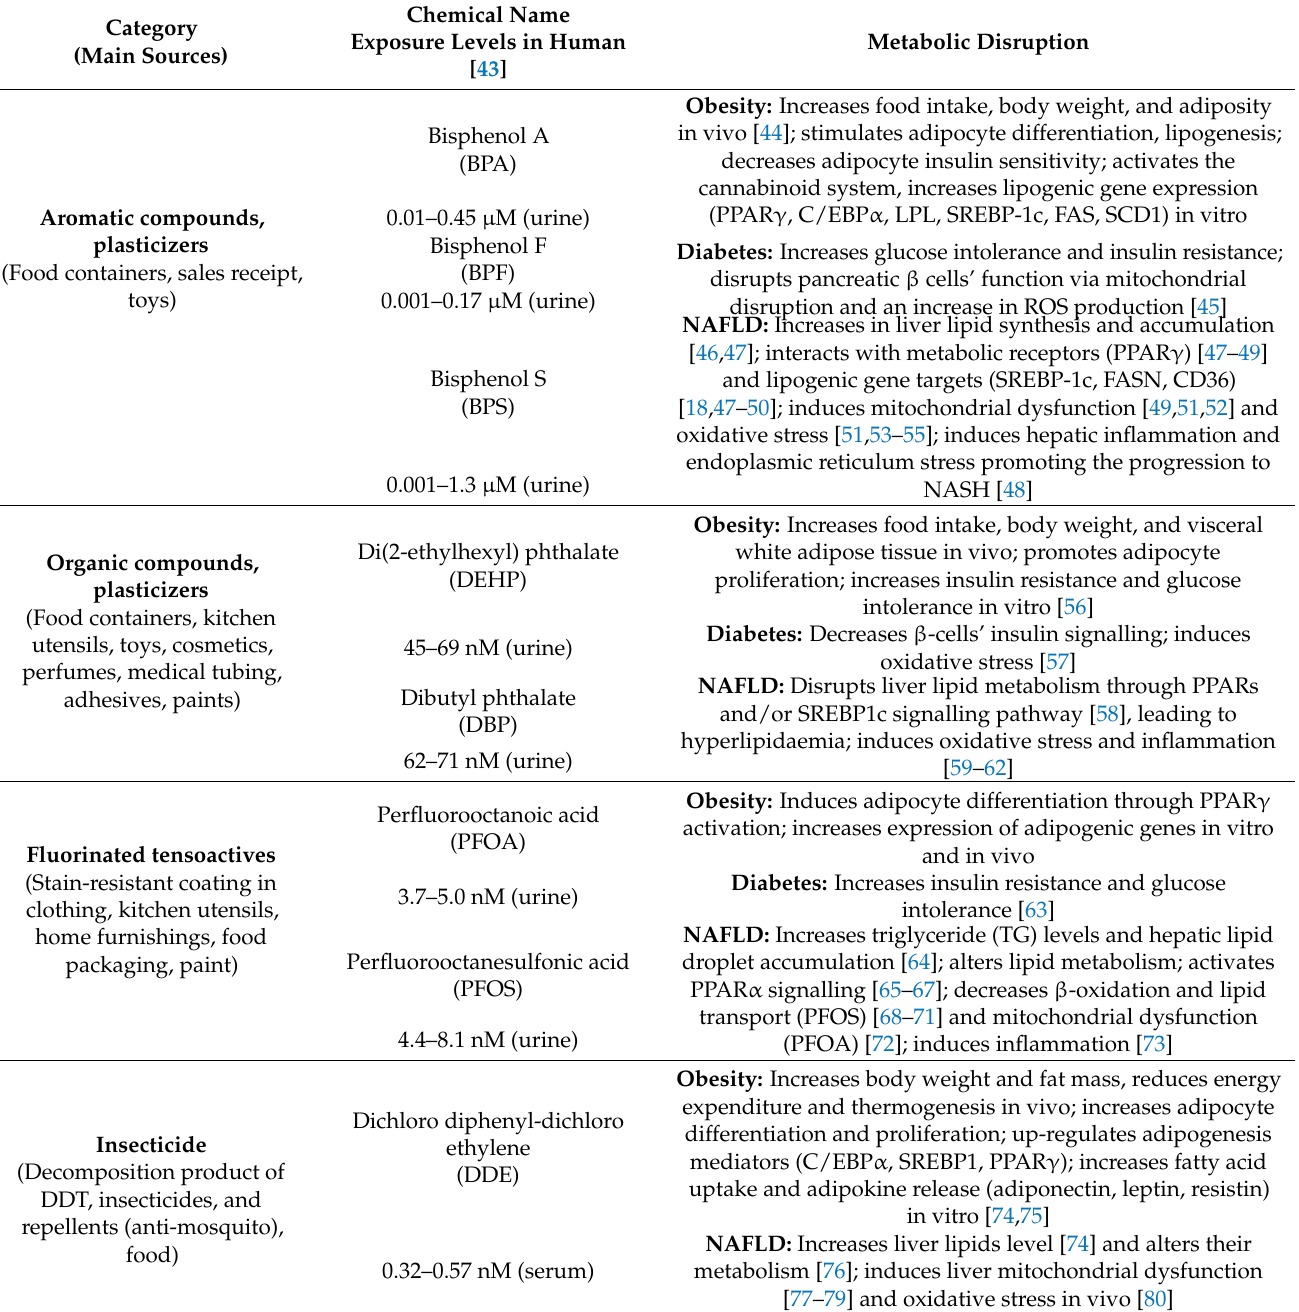
Table 1. List of the EDCs studied in the project and urinary or serum levels detected in the cohort study